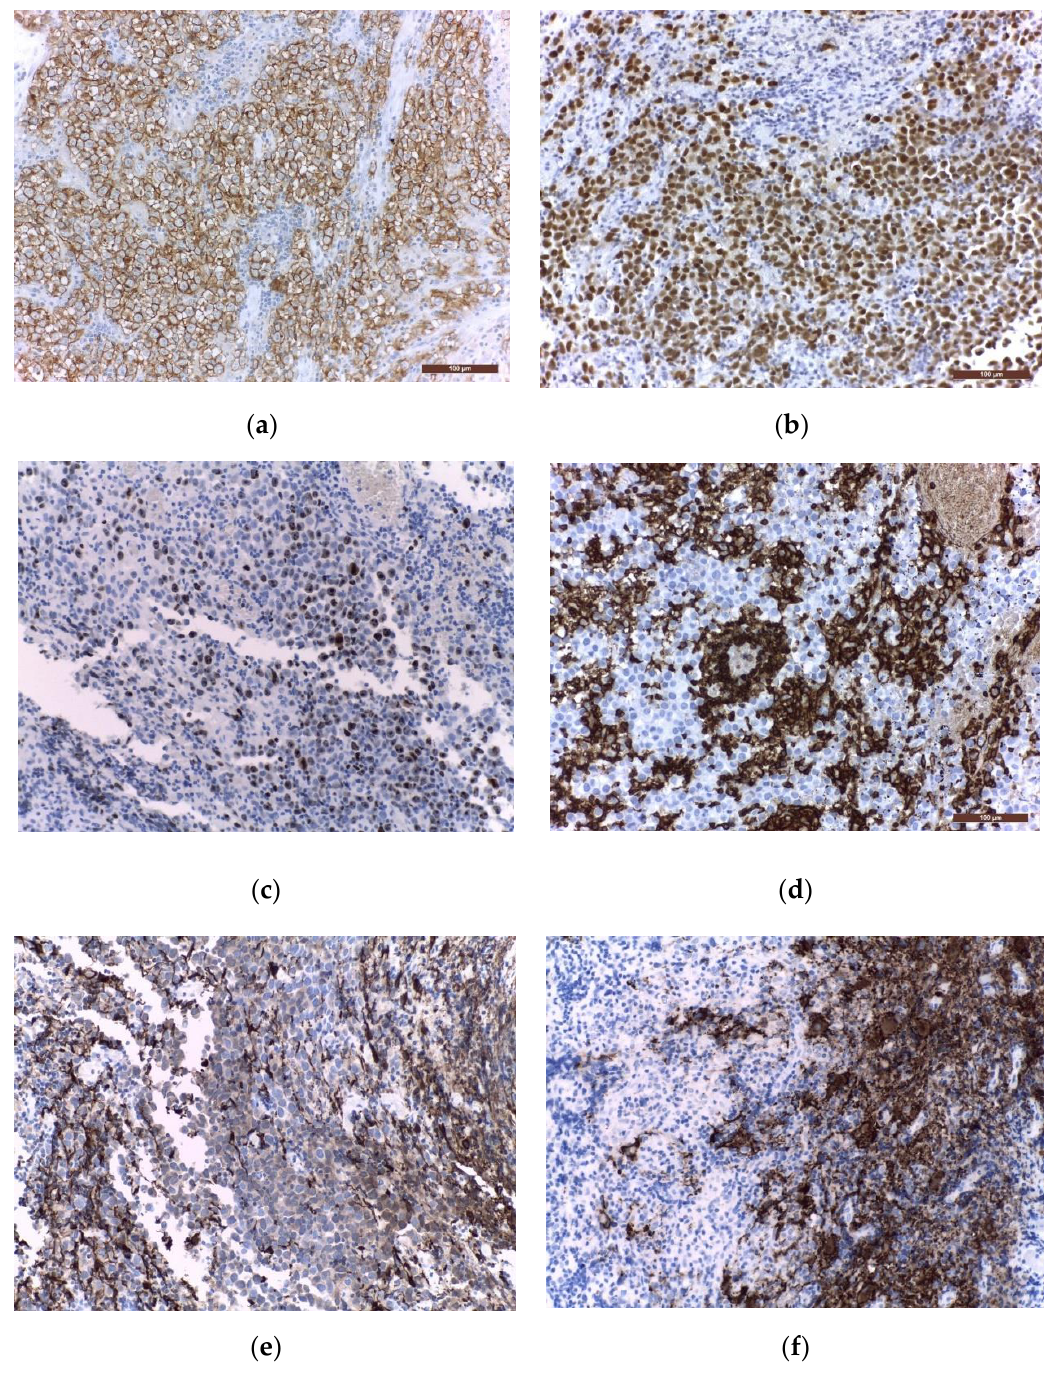
Figure 4. Immunohistochemical staining in extragonadal germinomas: ( a ) intense membranous and less intense cytoplasmic c-Kit/CD117 expression; ( b ) intense nuclear and less intense cytoplasmic OCT3/4 expression; ( c ) high Ki67 nuclear expression; ( d ) intense expression of leukocyte common antigen LCA/CD45 in stromal lymphocytes; ( e ) GFAP expression in glial pineal stromal cells in a case of pineal germinoma; ( f ) synaptophysin expression in the pinealocytes of a pineal germinoma; (200×).